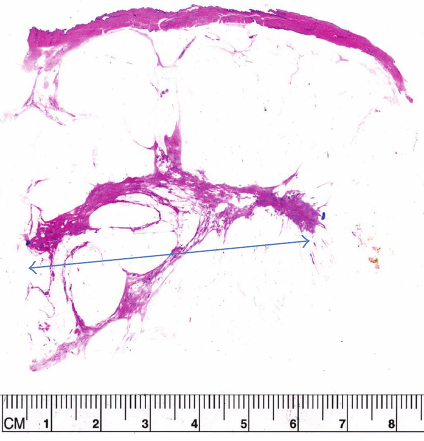
Figure 7: In this case, there is an area of 6cm of residual invasive and in situ carcinoma. This would be di ffi cult to measure in standard sections because of the di ffi culty in the orientation of the cut